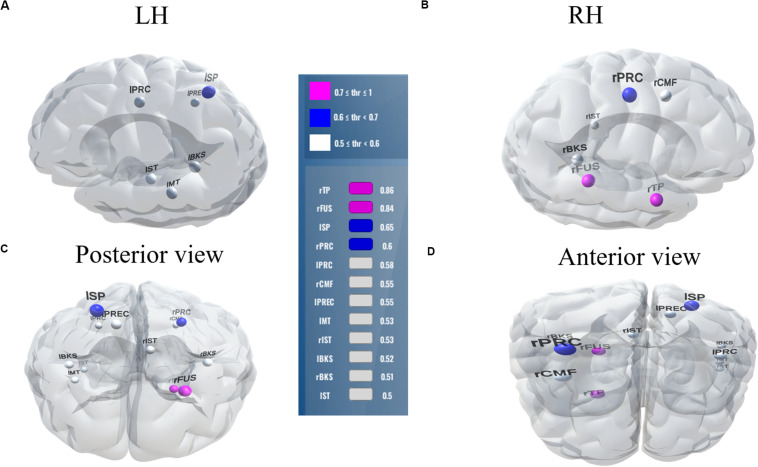
Stable (most consistent) neural network distinguishing NH and HI listeners during clear speech processing. Visualization of brain ROIs corresponding to 0.50 stability threshold (12 top selected ROIs which segregate groups at 81.8%) for clear speech perception. (A) LH; (B) RH; (C) Posterior view; (D) Anterior view. Stability score (color legend): (0.70 ≤ pink ≤ 1.0); (0.60 ≤ blue < 0.70); (0.50 ≤ white < 0.60). L, Left; R, Right; rTP, temporal pole R; rFUS, fusiform; lSP, sperior parietal L; rPRC, precentral R; lPRC, precentral L; rCMF, caudal middle frontal R; lPREC, precuneus L; lMT, middle temporal L; rIST, isthmuscingulate R; lBKS, bankssts L; rBKS, bankssts R; lST, superior temporal L.